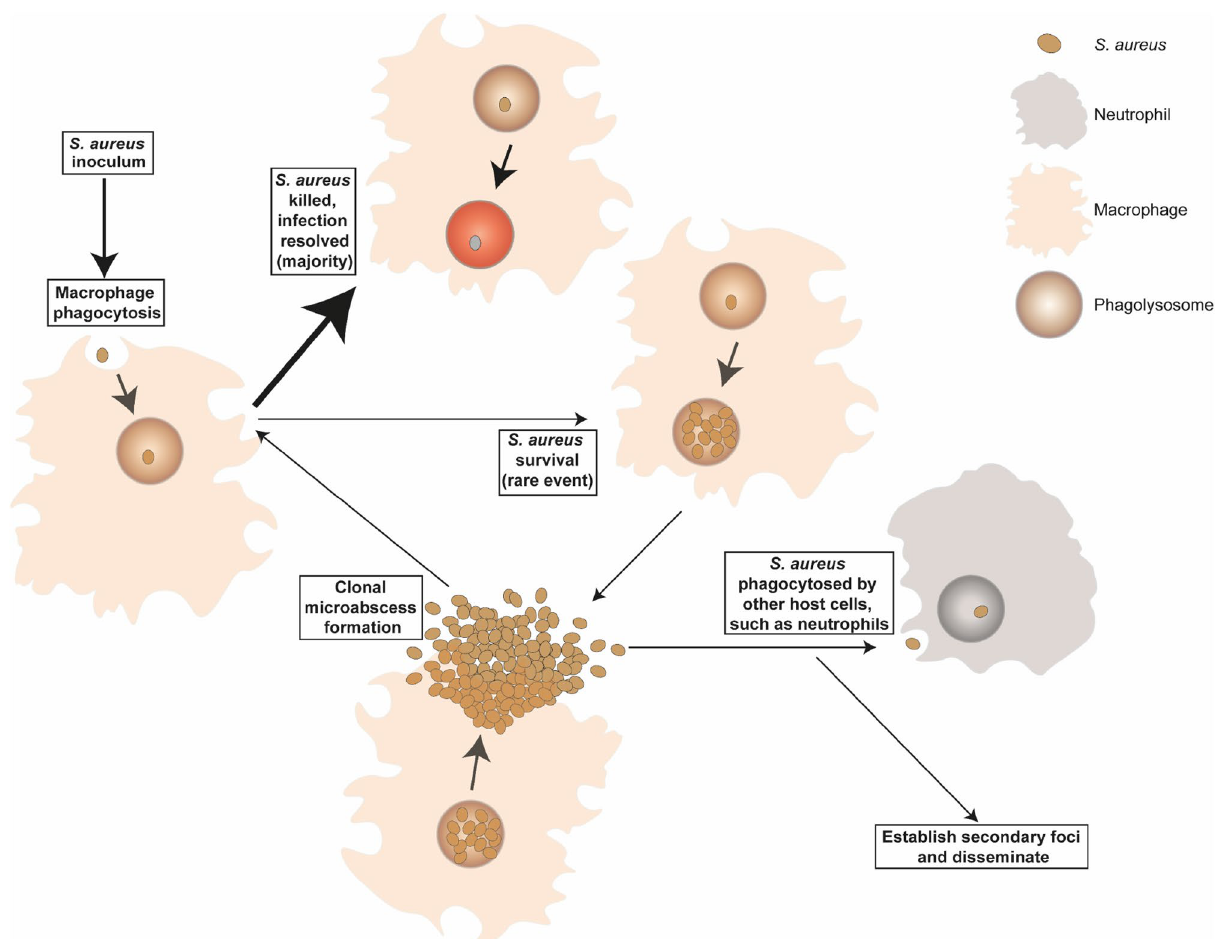
Figure 4. S. aureus clonal population dynamics. S. aureus enters the body and is phagocytosed by macrophages. The majority of S. aureus are killed in the phagolysosome vacuole, but a small proportion may survive to divide, expanding clonally until the bacteria escape from the macrophage to form clonal microabscesses, which can then either seed local abscesses, be re-phagocytosed by macrophages, or be phagocytosed by other immune cells, such as neutrophils. S. aureus may also establish secondary foci and disseminate to distant